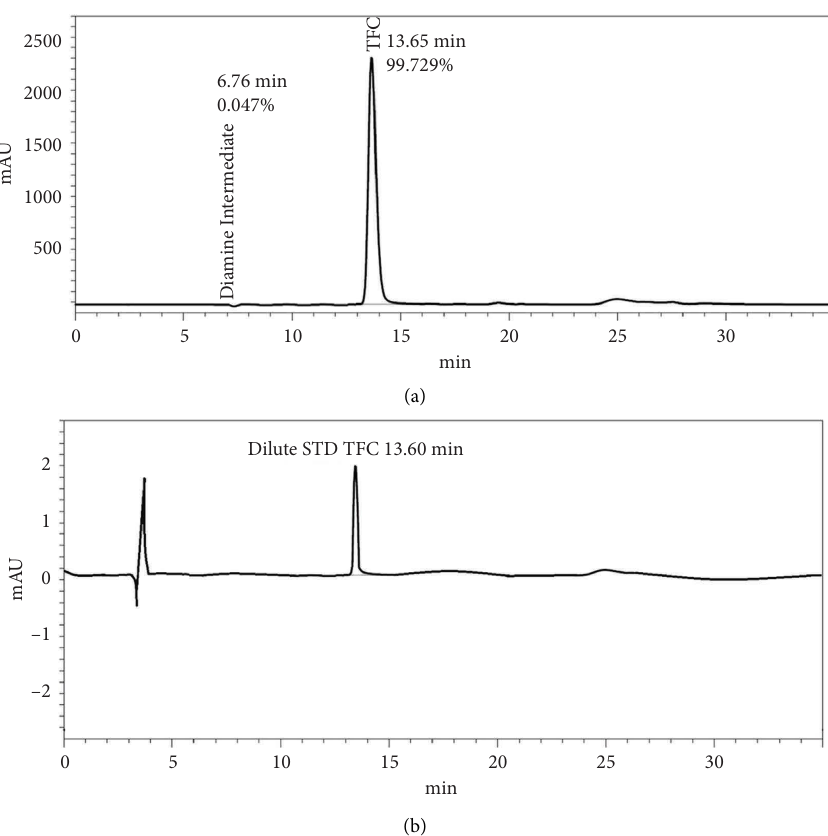
Figure 2: Te chromatograms of the related impurity analysis for the TFC sample at 1000ppm (a) and for the diluted standard at 1ppm (b) concentration prepared by using the reverse phase HPLC